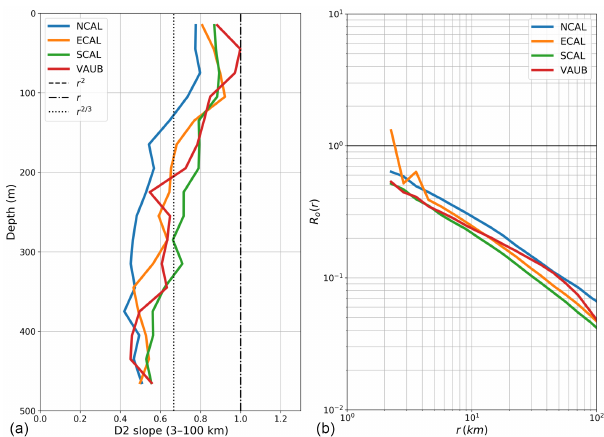
Figure 6. Evolution of the total structure function slope with depth for the range of 3–100km (a) . Classic power laws ( r 2 , r , r 2 / 3 ) are plotted for reference with oceanic turbulence theories. Scale- dependent Rossby number Ro estimated from the total structure function averaged over depth (b)